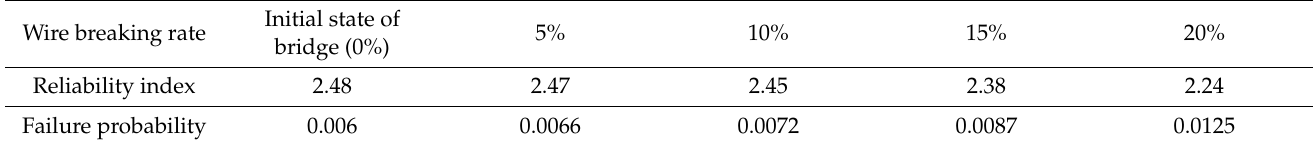
Table 12. Flutter failure probability corresponding to different wire breaking rates.